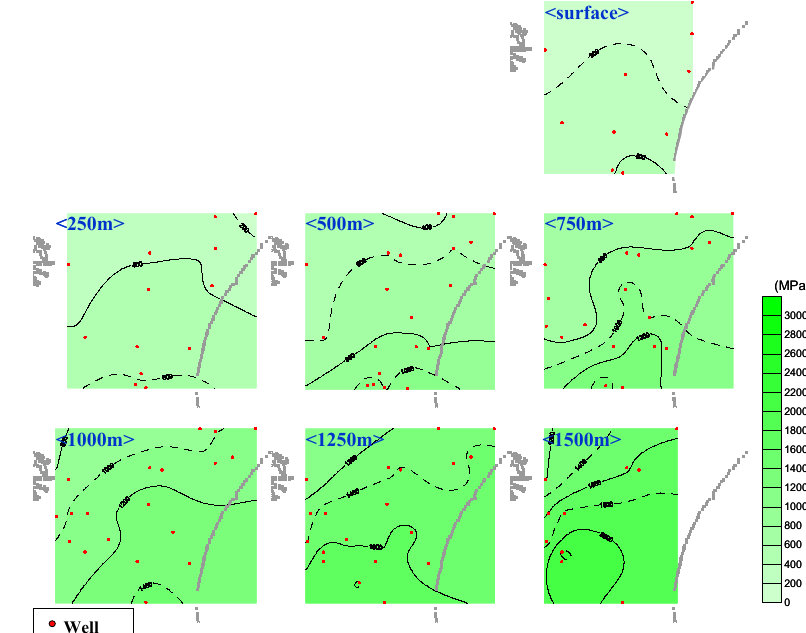
Figure 4. Estimated Young’s modulus in each 250m depth interval of reservoir.